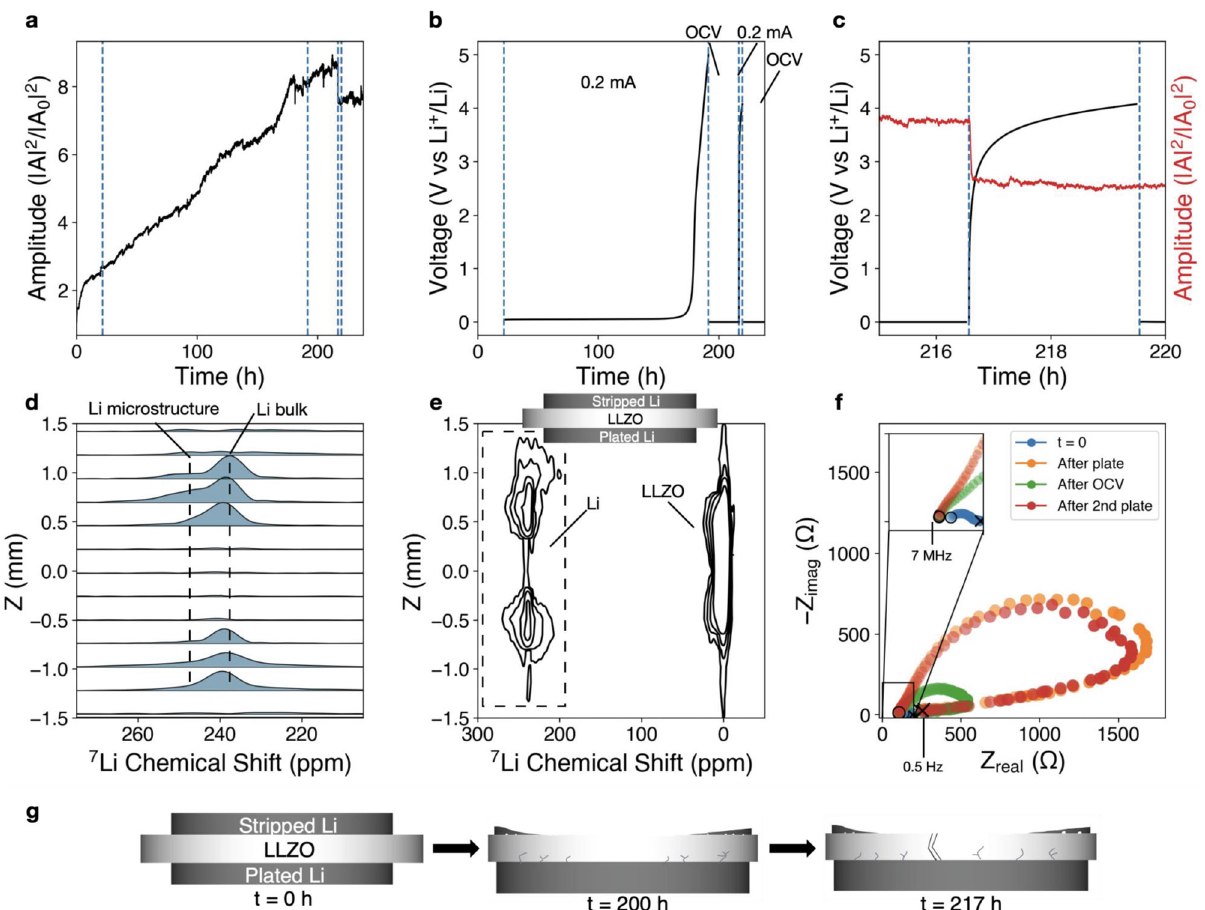
Fig. 3 Lithium metal – LLZO interface at 7.4 MPa. Polarization test of Li (s) – LLZO interface at 7.4 MPa stack pressure conducted in a Li/LLZO/Li cell. After a few hours of initial mechanical equilibration, 0.2 mA/cm 2 is applied galvanostatically until the voltage cutoff of 5 V, followed by a 25 h OCV rest step, a second polarization step in the same direction, and a second OCV rest step. a Normalized acoustic amplitude. b Voltage pro fi le showing an increase in overpotential to voltage cutoff of 5 V during the galvanostatic current step of 0.2 mA/cm 2 . Vertical guidelines (dotted blue lines) are shown as a visual aid to delineate start and stop of galvanostatic current. c Zoomed in region of second polarization step which is accompanied by a sudden attenuation of acoustic amplitude. d 1D slices of ex situ 7 Li CSI highlighting the lithium metal region between 200 and 280 ppm, as indicated by the dashed region in e . e Ex situ 7 Li CSI contour plot showing microstructural lithium signal at the Li (s) – LLZO interface for both electrodes, as well as a small quantity of lithium metal signal extending through the body of the electrolyte. f Nyquist plot from potentiostatic electrochemical impedance spectroscopy conducted during initial OCV, after galvanostatic current to the voltage cutoff, after the 25 h OCV, and after the second plating step to the voltage cutoff. The open circle indicates the high-frequency start point (7 MHz), and the cross indicates the low-frequency end point (0.5 Hz). g Simpli fi ed cartoon illustration of interface behavior implied by the experimental data (not drawn to